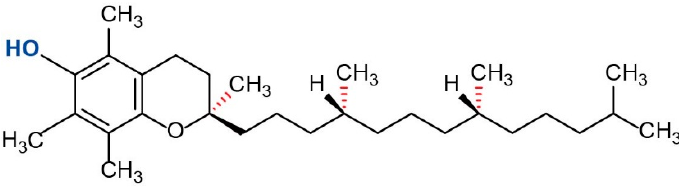
Figure 1. Structure of α -tocopherol.